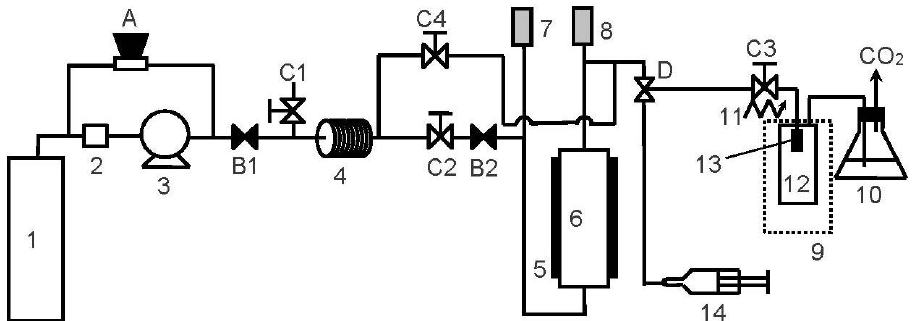
Figure 1. Experimental apparatus of the rapid expansion of the supercritical solutions (RESS) process